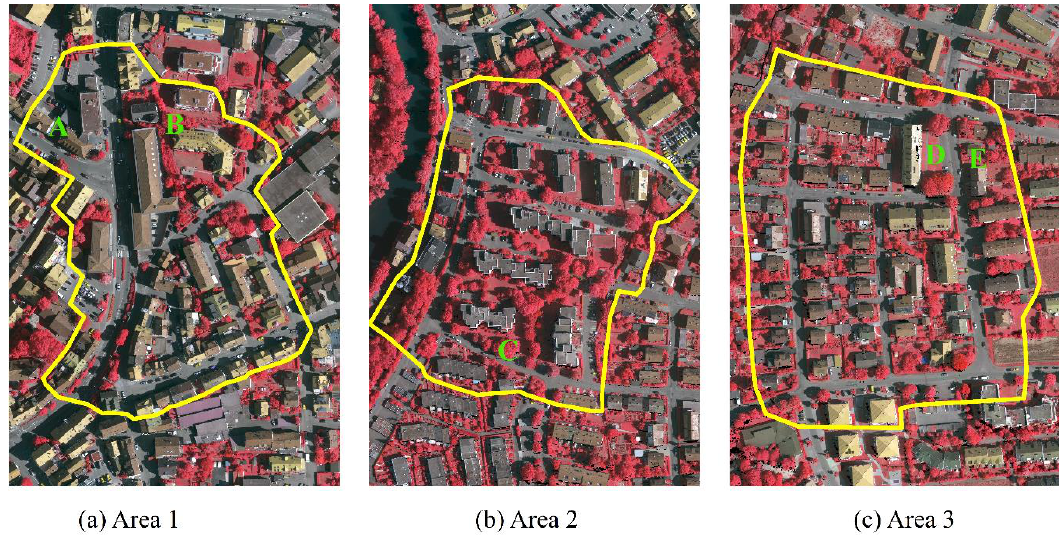
Figure 2. The three test sites in Vaihingen: inner city ( a ), high rise ( b ), and residential ( c ) [40].